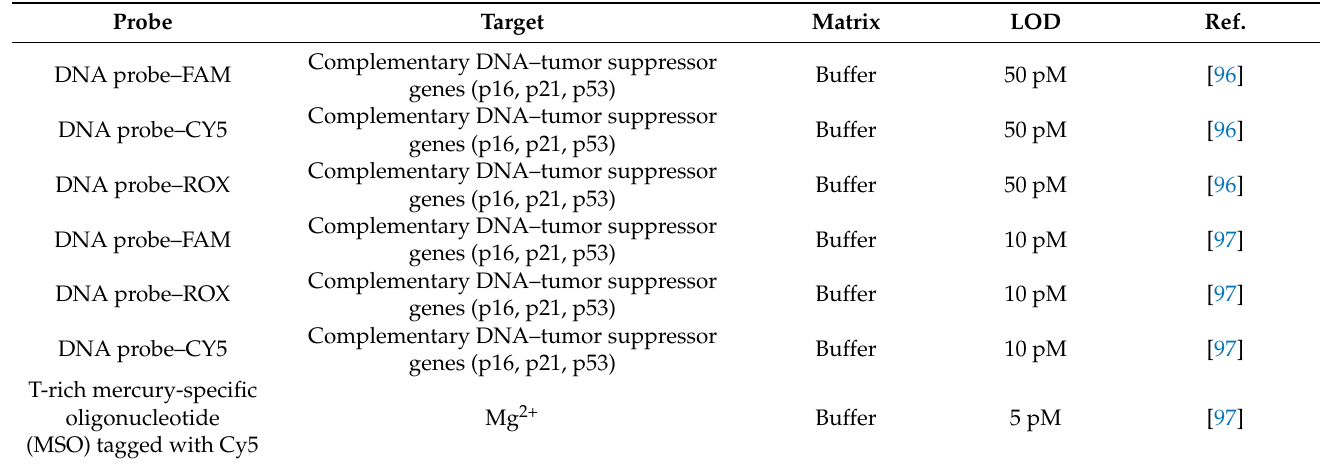
Table 2. Si NW as quencher in